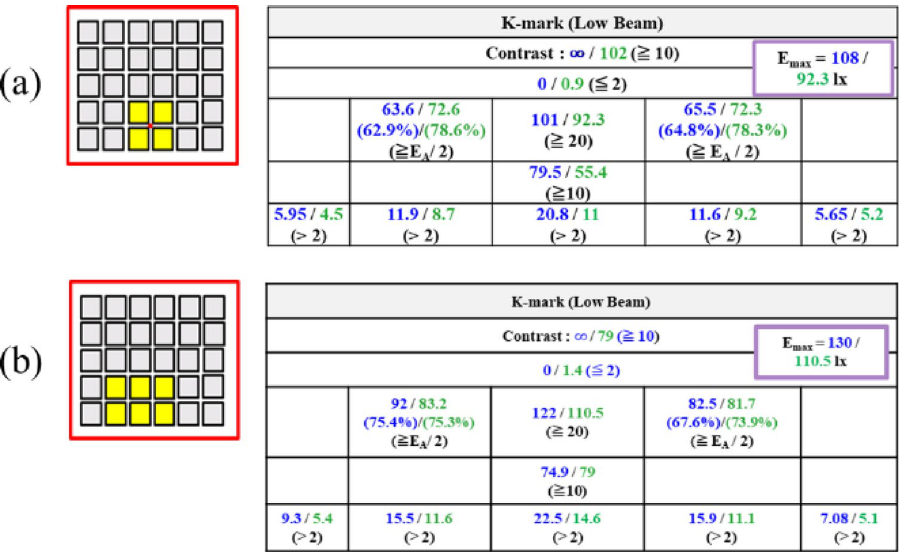
Figure 9. The check points for the low beam of the K mark regulation when ( a ) C4/D4/C5/D5 and ( b ) B4/B5 and C4/D4/C5/D5 were turned